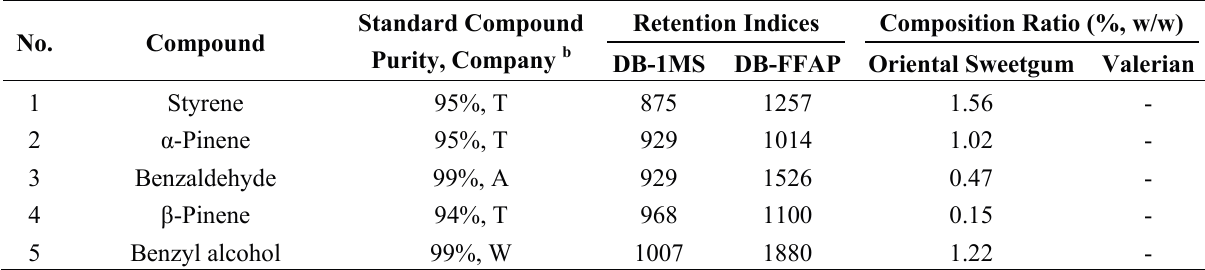
Table 1. Chemical composition a of oriental sweetgum and valerian essential